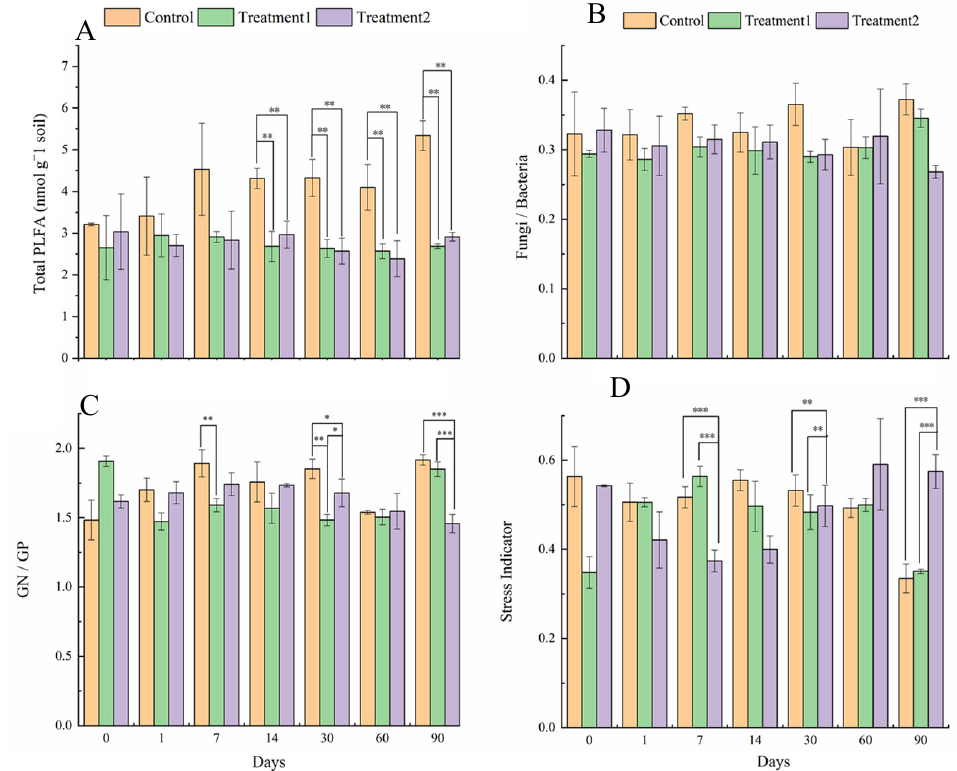
Figure 4. Effect of fomesafen on soil PLFA in the recommended usage and double the recommended usage groups. Data represent the mean ± SD of each soil sample selected at each time point. *, ** and *** represent the significance levels of 0.05, 0.01 and 0.001, respectively; without * indicates that the difference is not significant according to UNIANOVA with Duncan’s homogeneity test. Treatment 1 represent the recommended usage group, and Treatment 2 represents the twice the recommended usage group. (A) Total PLFA; (B) fungi/bacteria; (C) GN/GP; (D) stress indicator .